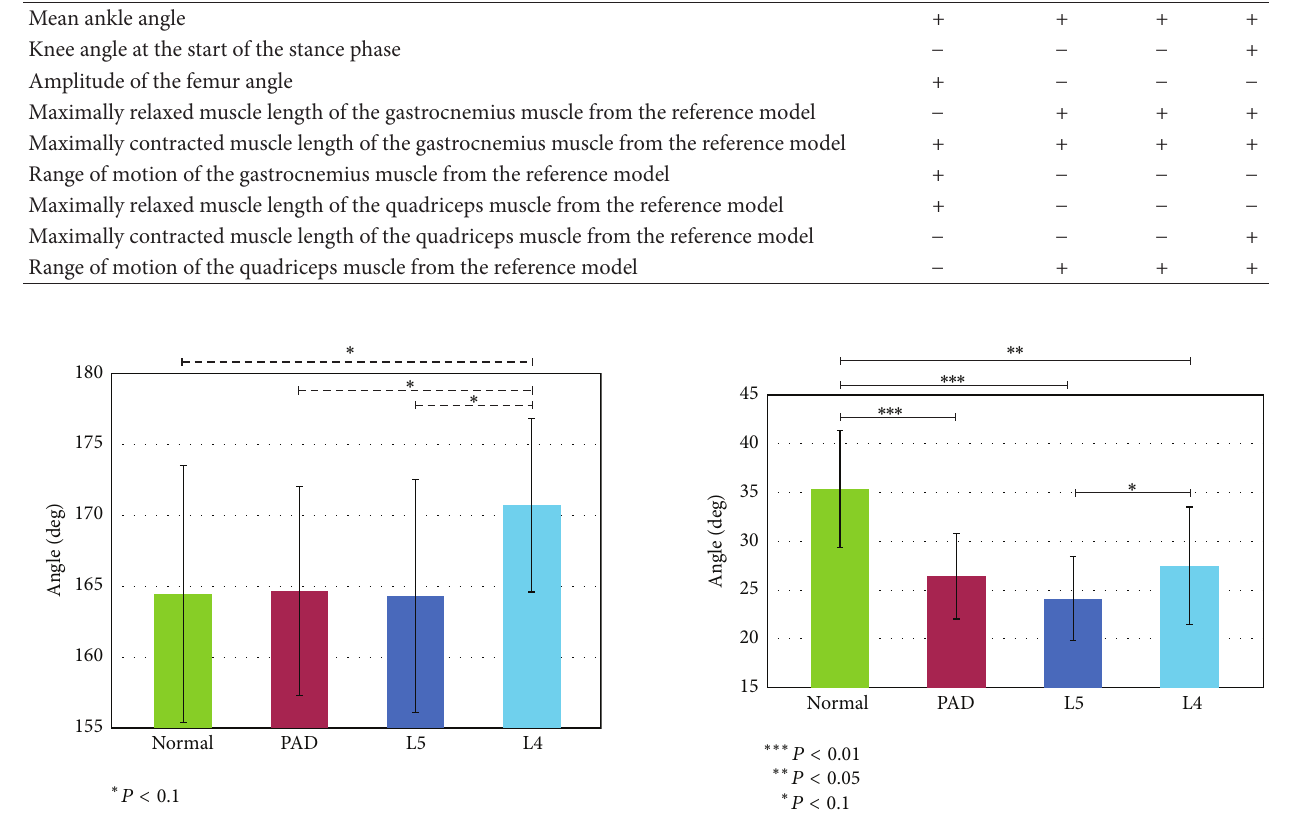
Figure 5: Knee angle at the start of the stance phase (the dashed lines show the results of t -tests conducted for each indicated pair).